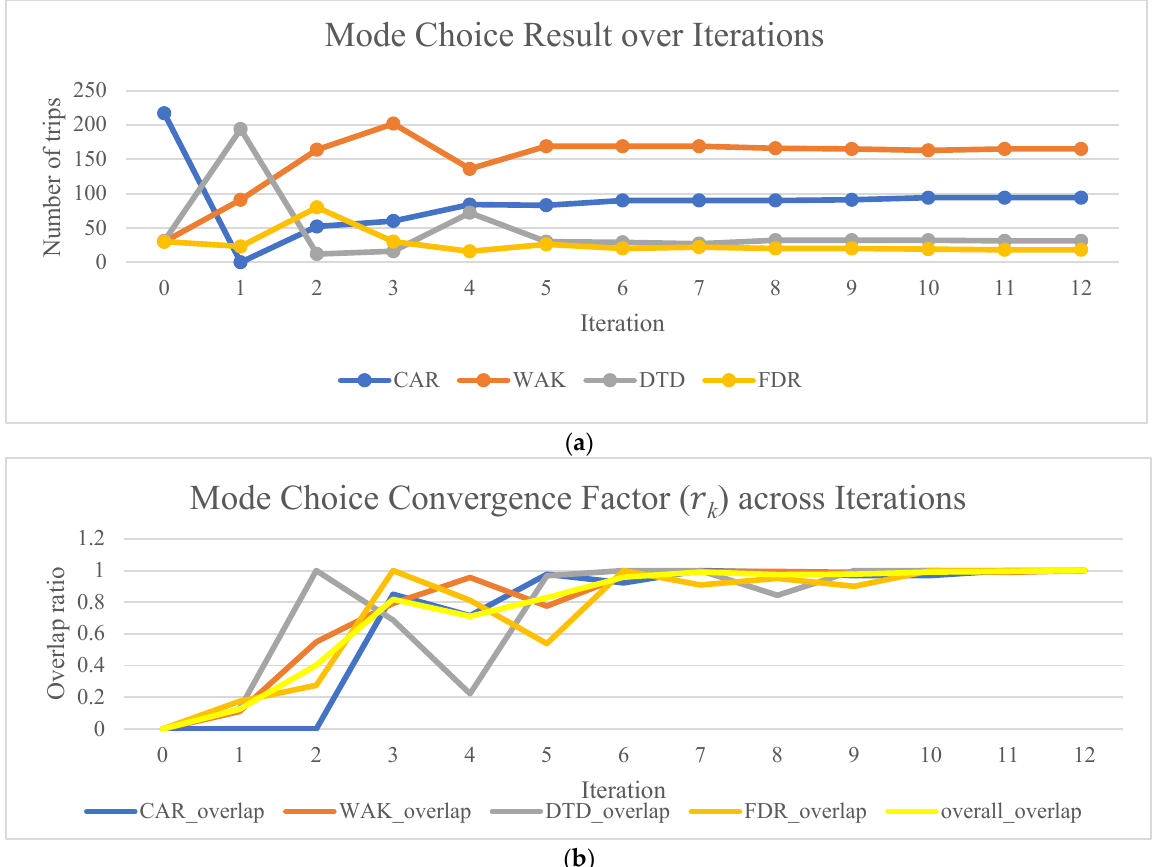
Figure 4. Mode choice results over iterations ( a ) trip frequencies, ( b ) overlapping rates.